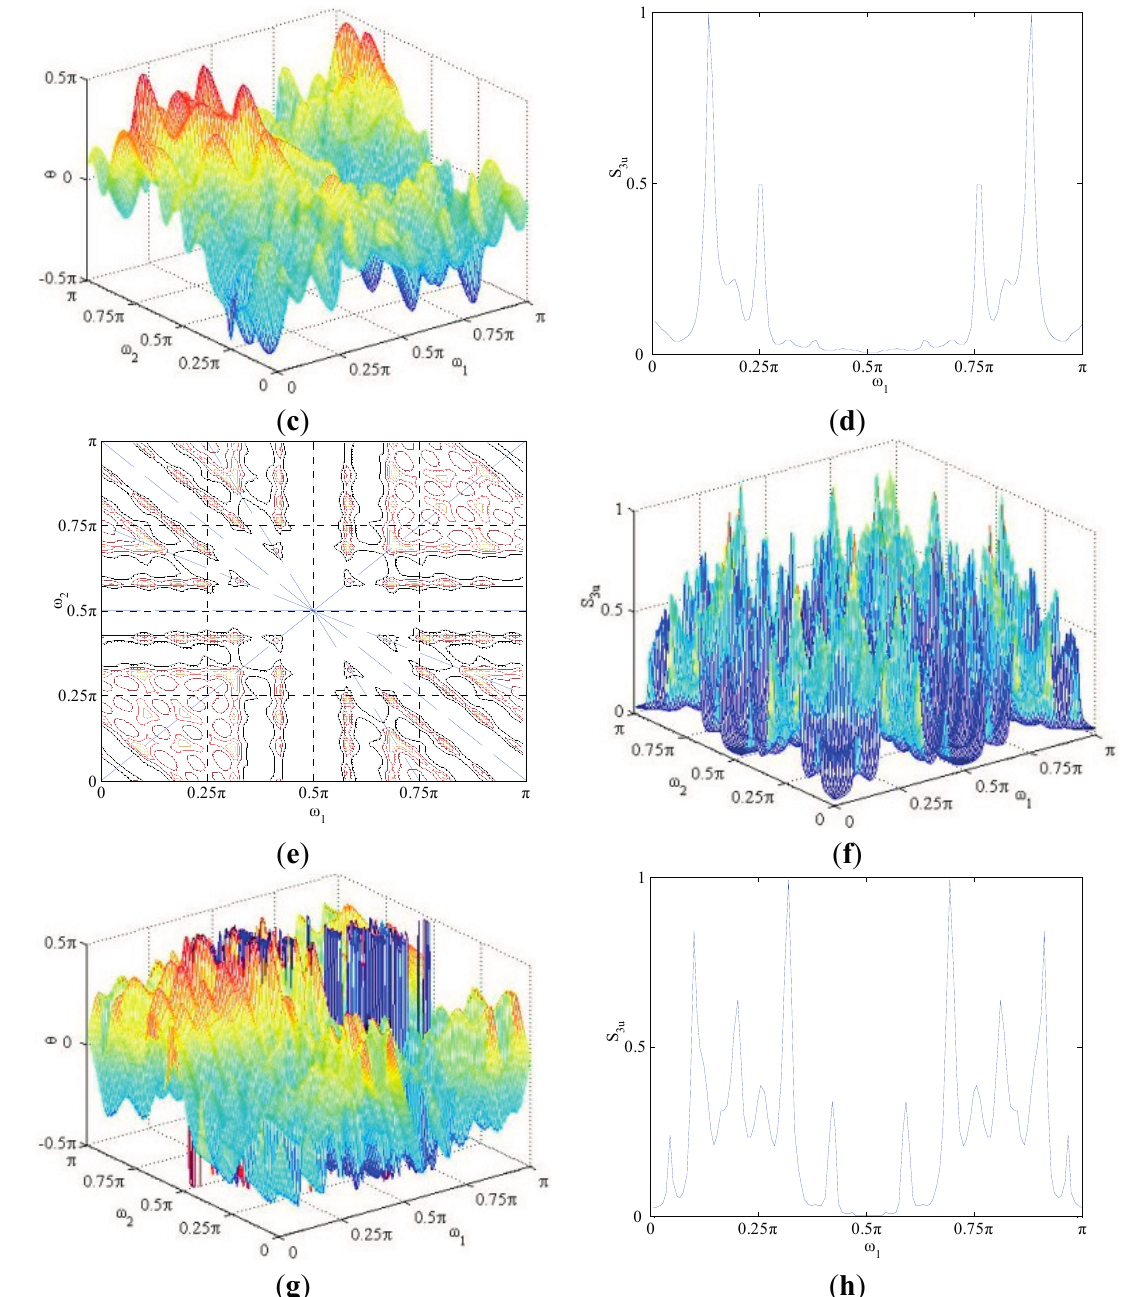
Figure 5. AR bispectra of vacuum cleaner. ( a ) Normal contour; ( b ) Normal amplitude; ( c ) Normal phase angle; ( d ) Normal 1½ - D slices; ( e ) Arc fault contour; ( f ) Arc fault amplitude; ( g ) Arc fault phase angle; ( h ) Arc fault 1½-D